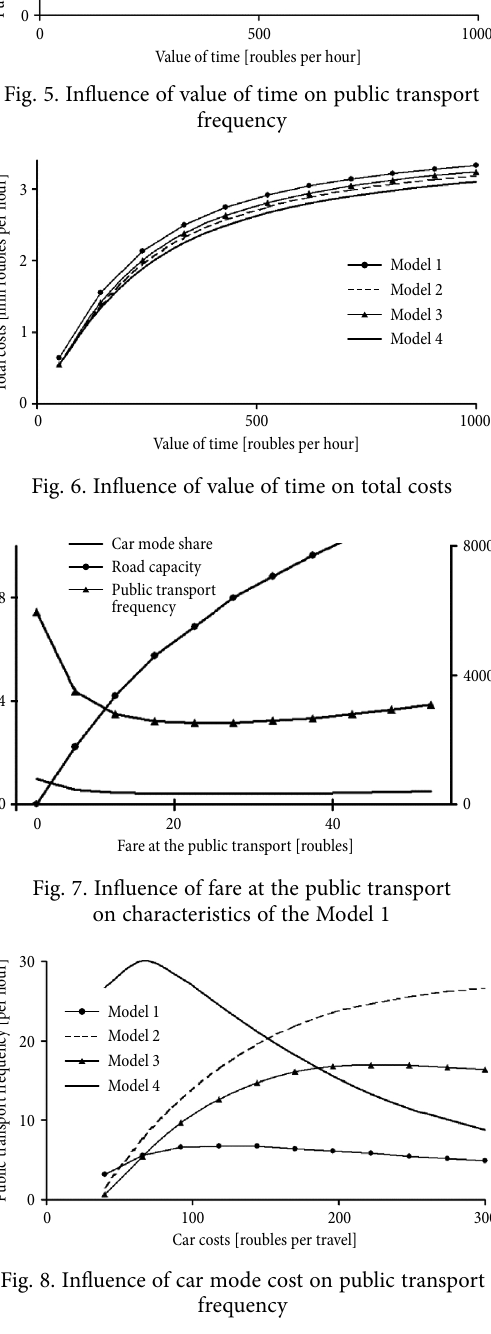
Fig. 4. Influence of value of time on road capacity